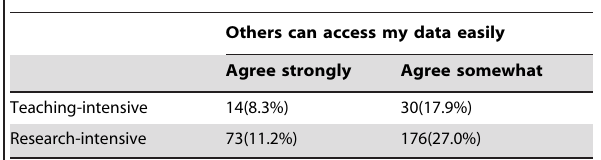
Table 29. Data access by activity.